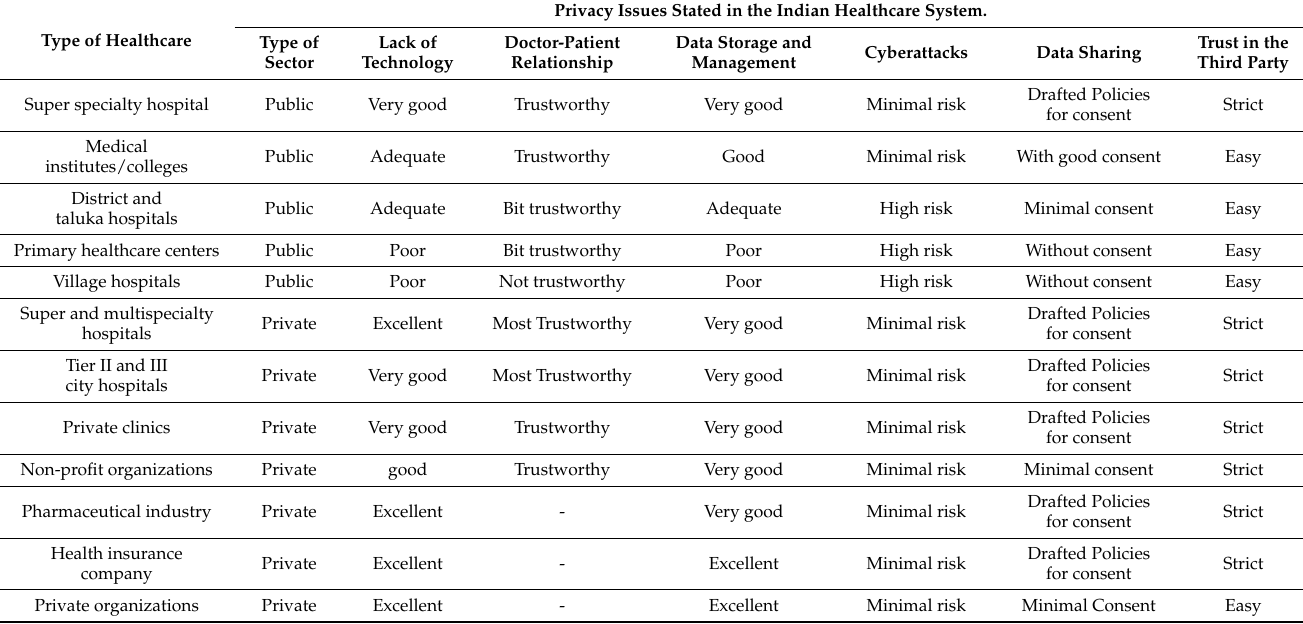
Table 9. Privacy issues stated in the Indian healthcare system. Privacy Issues Stated in the Indian Healthcare